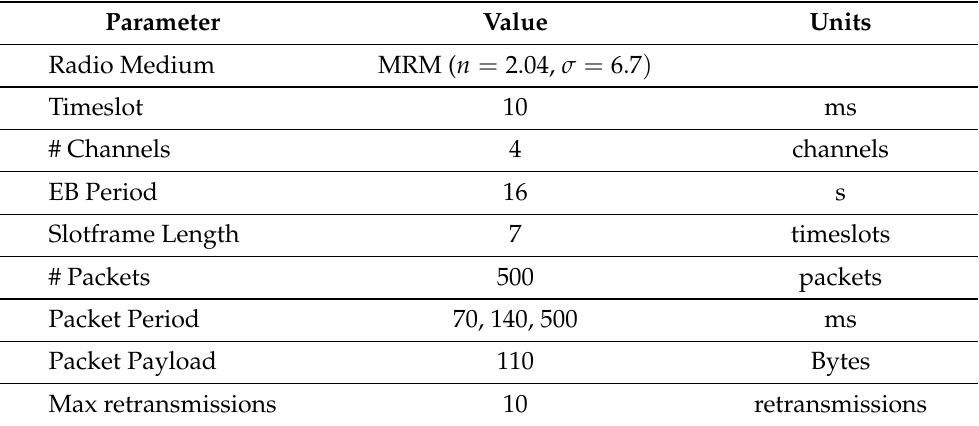
Table 2. Simulation